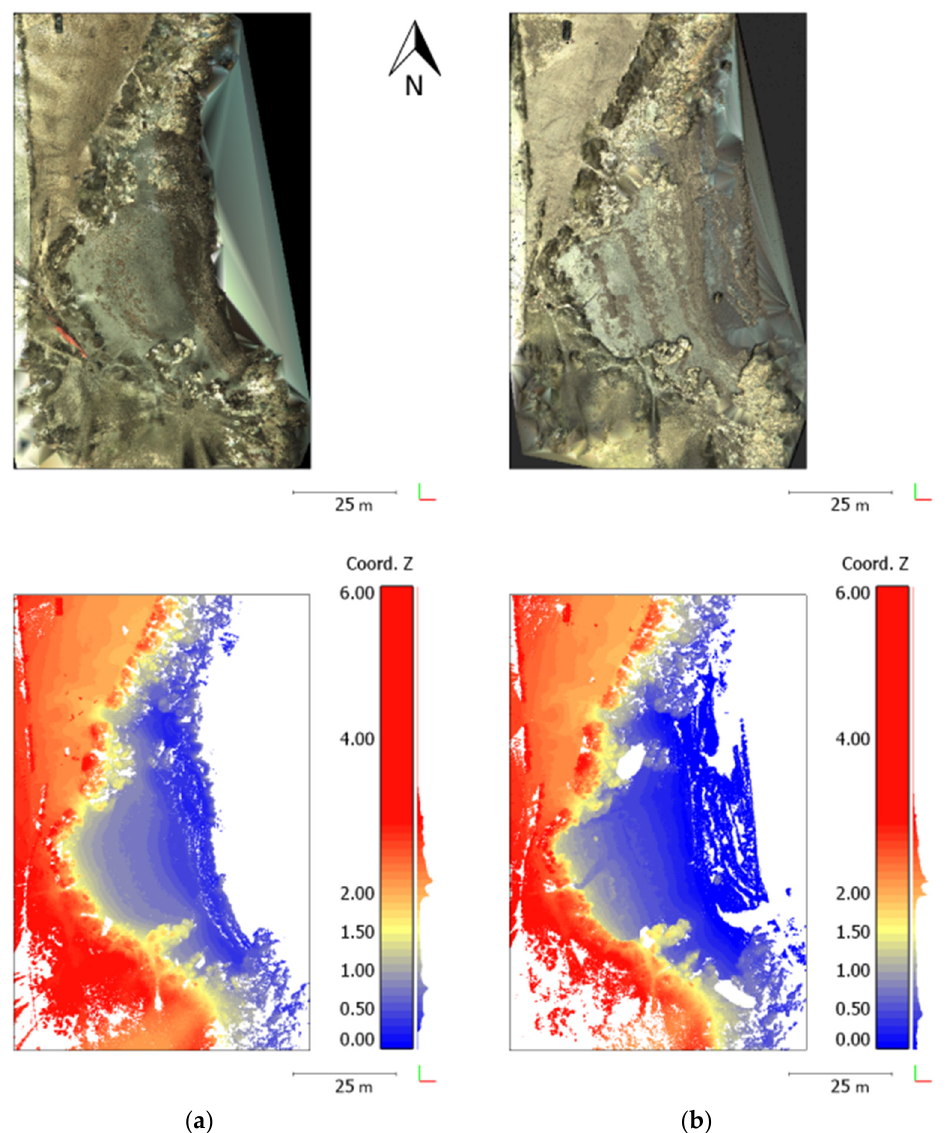
Figure 5. Topographical top view of the 3DPC colored in RGB for the different sampling dates: ( a ) scenario A (mid-autumn): 24 November 2016; ( b ) scenario B (early spring): 22 March 2017.